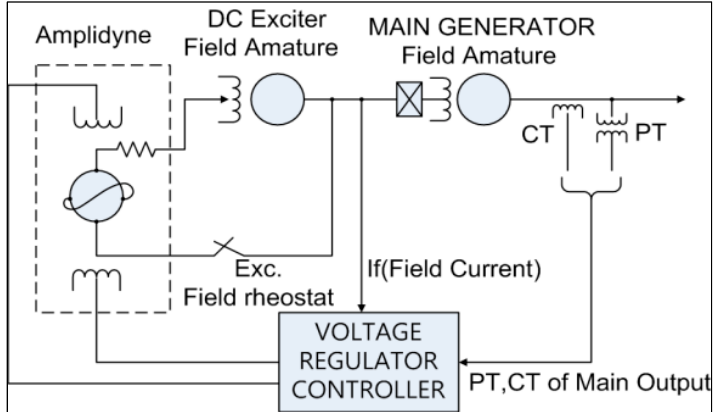
Figure 2. Generator output voltage control method for direct current excitation system.